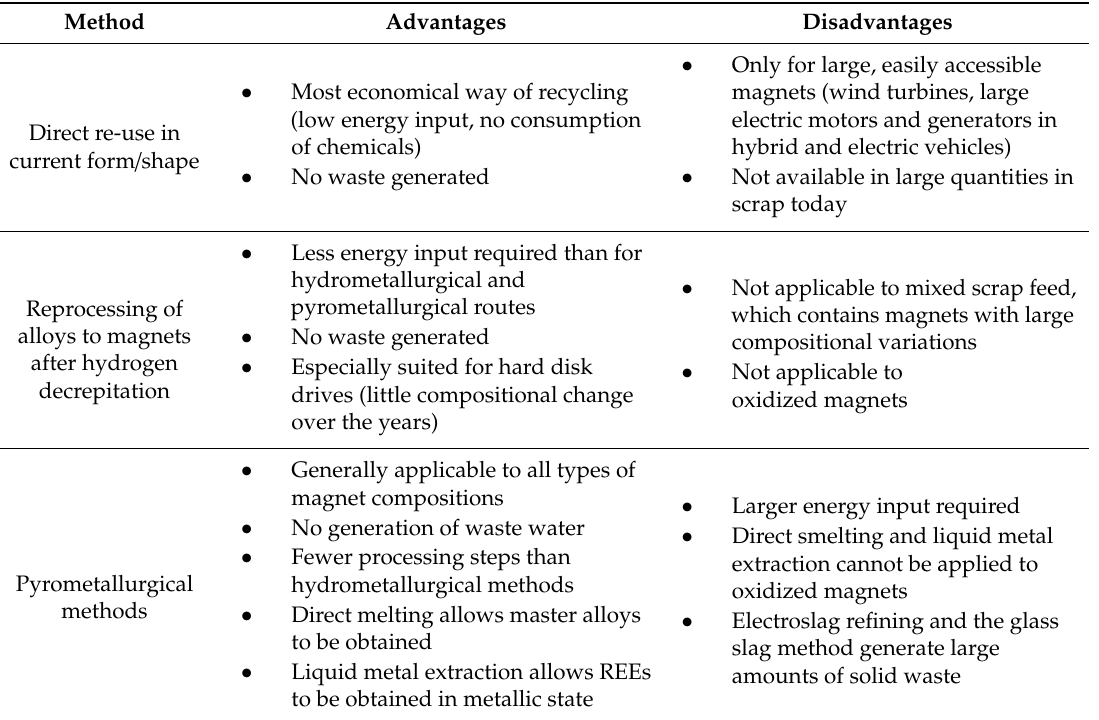
Figure 1. The proportion of different applications around the global NdFeB magnet market, data from [3]. Table 1. Overview of the advantages and disadvantages of di ff erent methods for NdFeB magnet scrap recycling, Reproduced with permission from [38]; published by Elsevier,